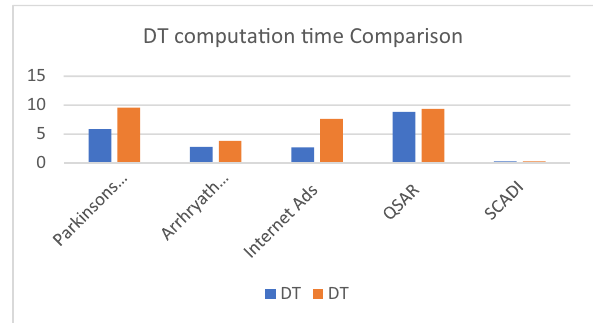
Figure 4: Comparison of the execution time of FrbyCC and PCA with DT classi fi er.